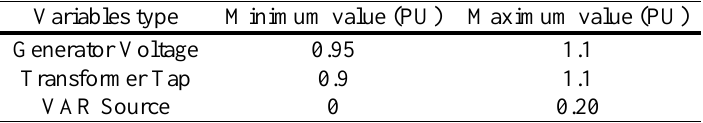
Table 1. Constraints of control variables.